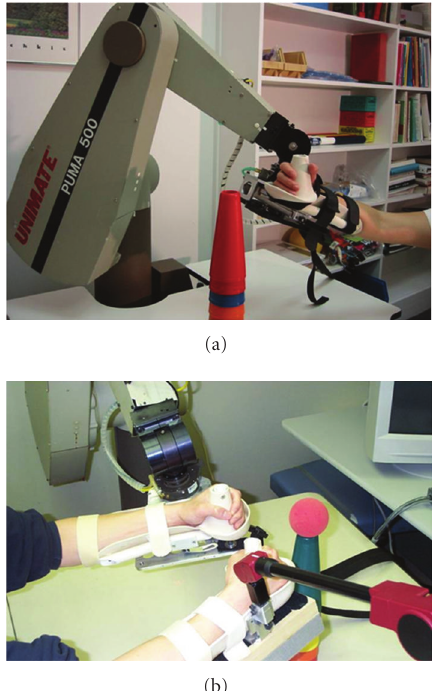
Figure 9: MIME. (a) Unilateral mode. (b) Bilateral mode. Reprinted with permission (funding: US Department of Veterans A ff airs Rehabilitation Research and Development Program).